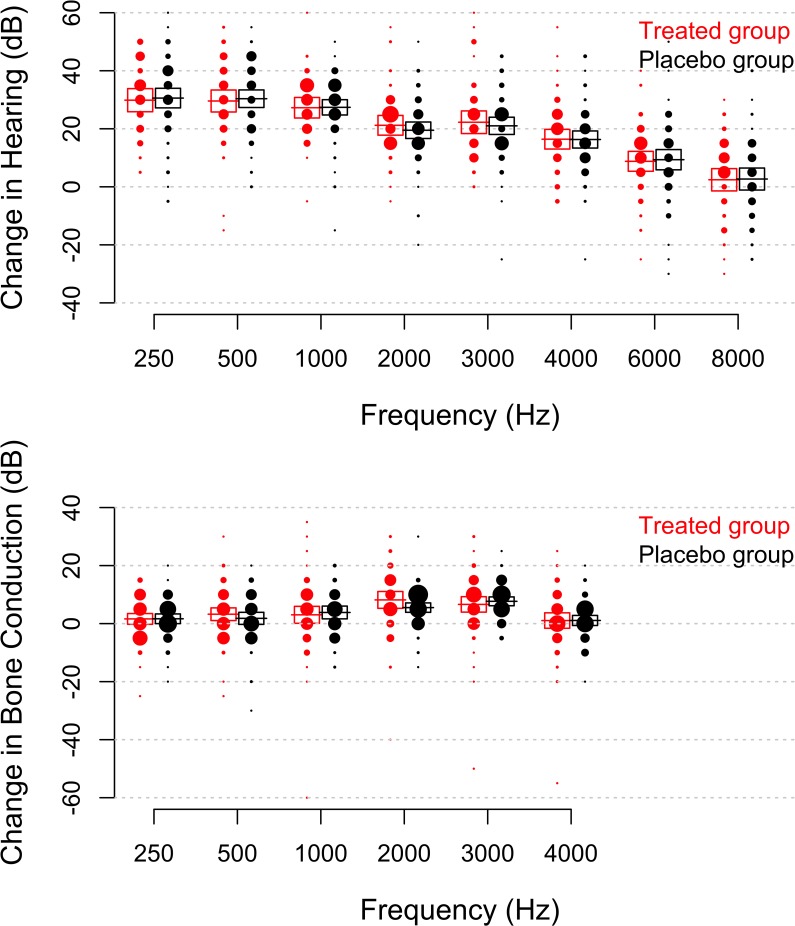
(Upper graph).Change in hearing thresholds one year after surgery (as compared to measurements obtained before the operation). The size of each dot corresponds to the number of patients (obtained from the histogram for each frequency; 5 dB bins). Boxes enclose the 95% confidence interval and the horizontal lines give the mean at each frequency. One patient with complete sensorineural hearing loss after surgery is omitted from the plot. (Lower graph). Change in bone-conduction thresholds at 1 year. Dot scaling is identical in both graphs.